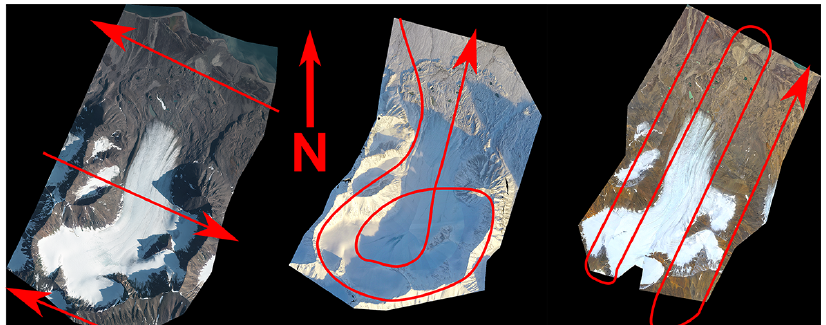
Figure 9. Orthoimages produced for the UltraCam data of 2010 (left), GoPro 2014 (middle), and GoPro 2015 (right). Flight lines are indicated in